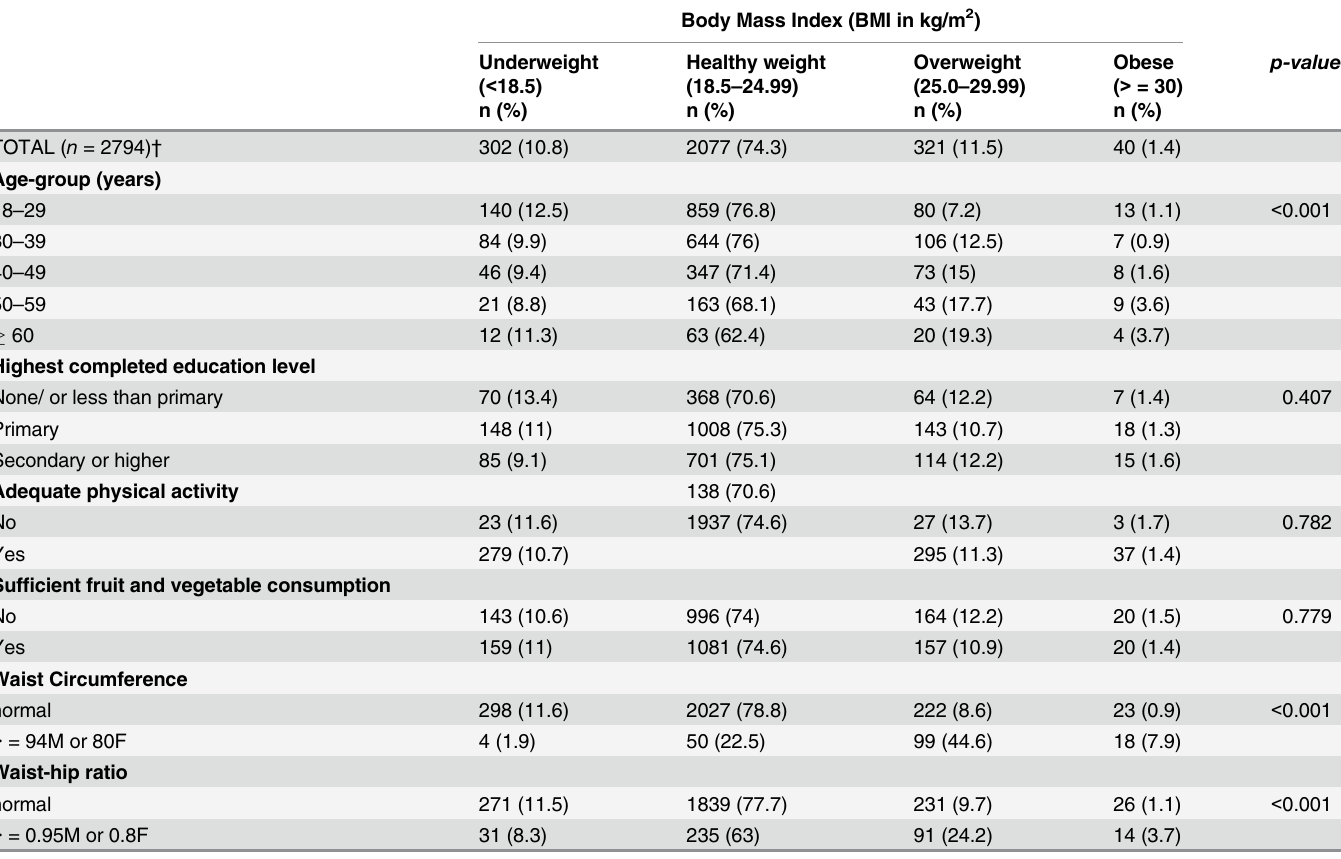
Table 5. Body mass index by individual characteristics for male adults 18 years and older, Nairobi